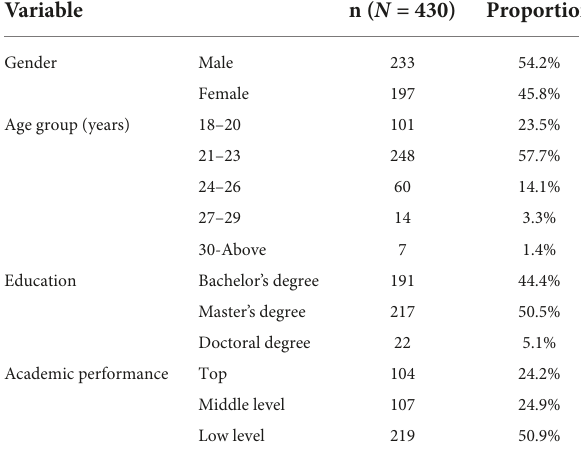
TABLE 1 The demographic characteristics of all the